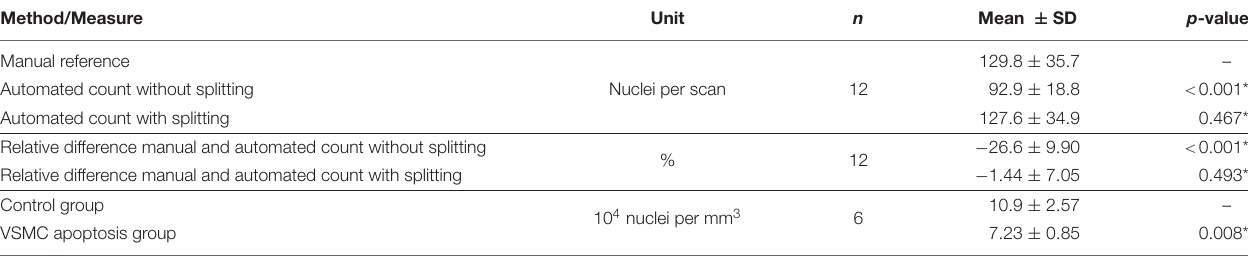
TABLE 2 | Nuclear splitting results in insignificant differences between mean manual and automated nucleus counts.